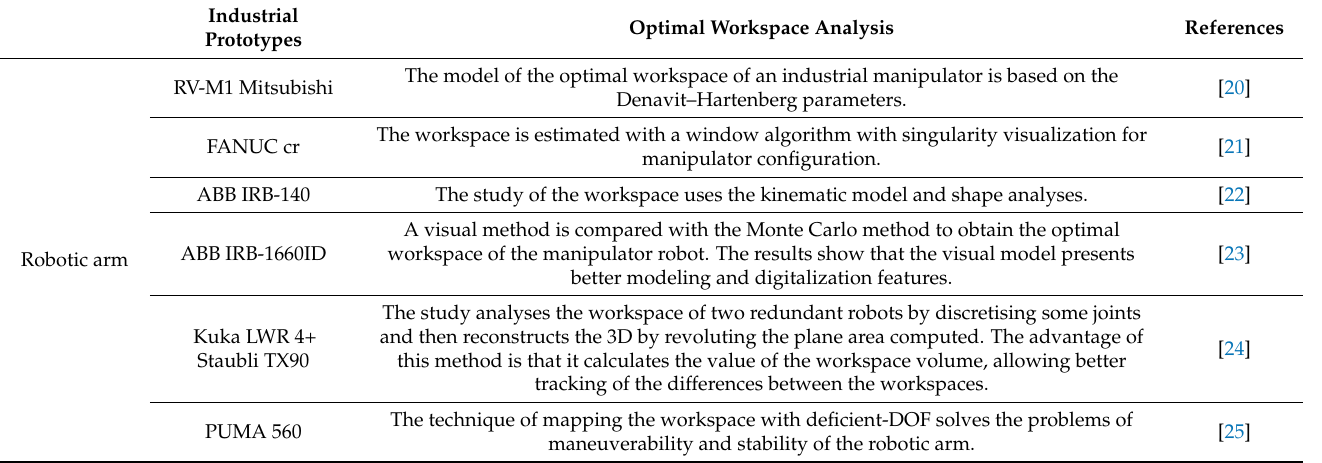
Table 1. Methods to obtain the optimal workspace for industrial